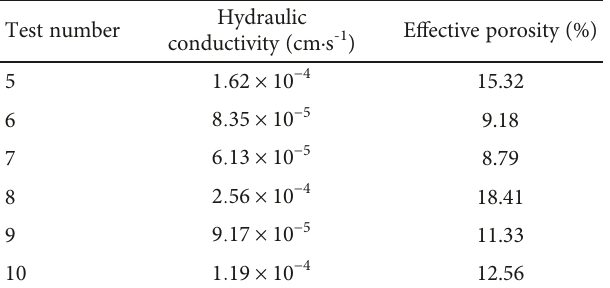
Table 2: Seepage properties of the fault fi llings.